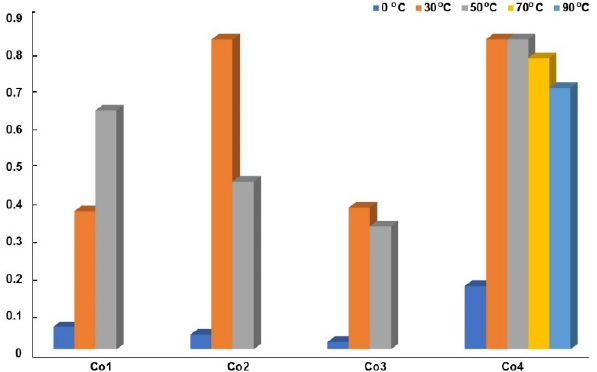
Figure 3. Influences of polymerization temperature on polymer yields. Temperature also imposed a significant influence on the microstructures and molec- ular weights of the resultant polymers. For Co4 -mediated polymerizations, a monotonous cis -1,4- content decrease of from 98.1% to 86.9% occurred when the temperature increased from 0 °C to 90 °C. Such a decrease can be ascribed to the facilitated anti – syn isomerization of the terminal π -allylic propagating unit through the π – σ -rearrangement at high temper- atures, leading to decreased cis -1,4- content and simultaneously increased trans -1,4- units (Figure 4). Regarding the molecular weight of the resultant polymers, monotonously de- creased M n s due to facilitated chain transfers at high temperatures were revealed.